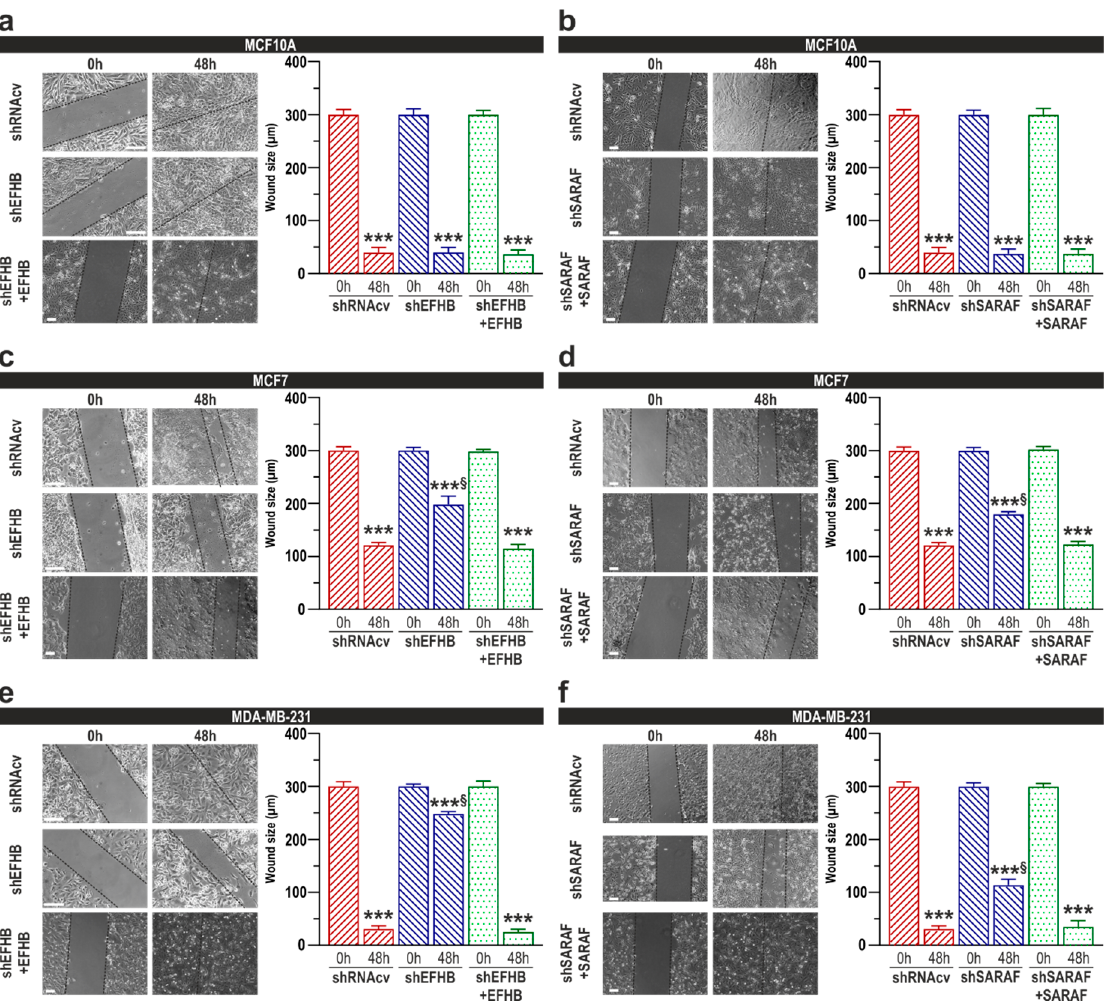
Figure 5. EFHB and SARAF are required for cell migration in breast cancer and pre-neoplastic epithelial cells. MCF10A ( a , b ), MCF7 ( c , d ), and MDA-MB-231 cells ( e , f ) were transfected with shEFHB alone or in combination with EFHB expression plasmid, shSARAF alone, or in combination with SARAF expression plasmid or scramble plasmids (shRNAcv), as indicated. Forty-eight hours after transfection cells were subjected to the wound healing assay, as described in Methods. Images were acquired at 0 and 48 h from the beginning of the assay. The dotted lines define the areas lacking cells. The bar graphs represent the wound size, in micrometers, at the different conditions, expressed as the mean ± SEM of six independent experiments. *** p < 0.001 compared to the time = 0 h. § p < 0.001 compared to the corresponding time in shRNAcv-transfected cells. Scale bar: 50 µm.